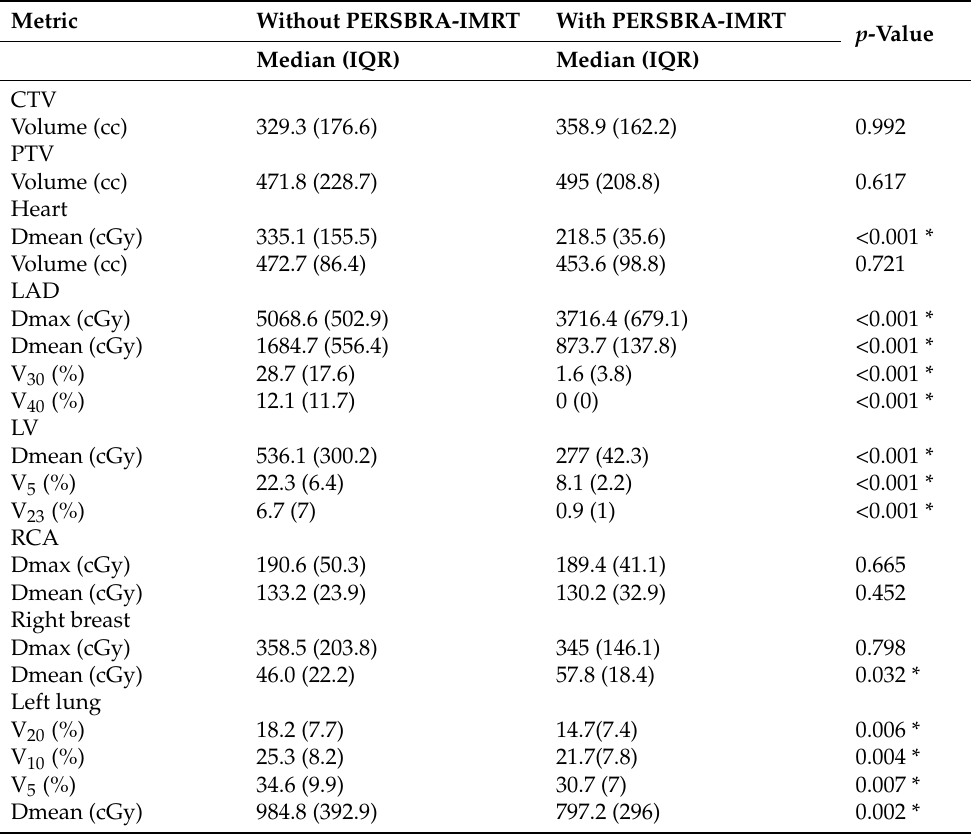
Table 4. Dose volume metrics without and with PERSBRA treatment plans using the Wilcoxon signed-rank test.